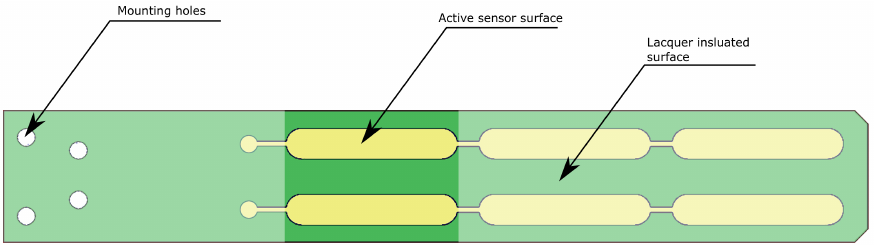
Figure 6. The printed circuit board (PCB) for the electrical conductivity